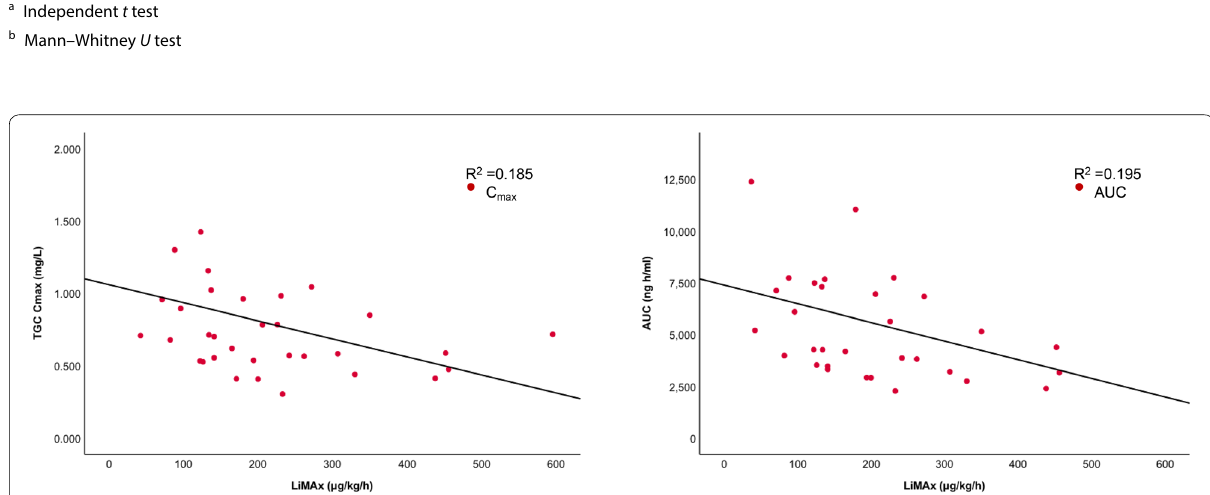
Data are presented as median and interquartile range (25th to 75th percentile) LiMAx: maximum liver function capacity; INR: international normalized ratio; AST: aspartate aminotransferase; ALT: alanine aminotransferase; GGT: gamma-glutamyl transferase; ALP: alkaline phosphatase; MELD: model for end-stage liver disease